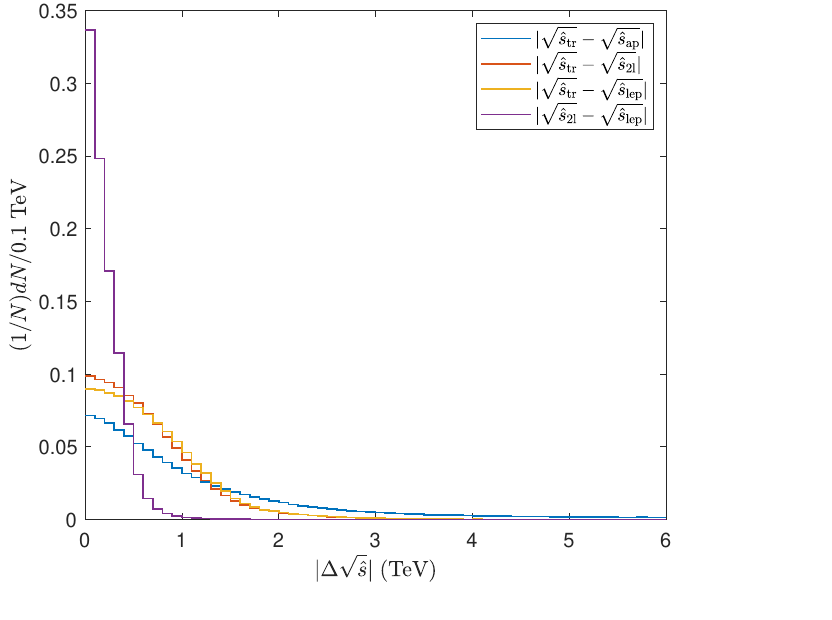
|√ √ ˆ s tr − ˆ s 2l | and